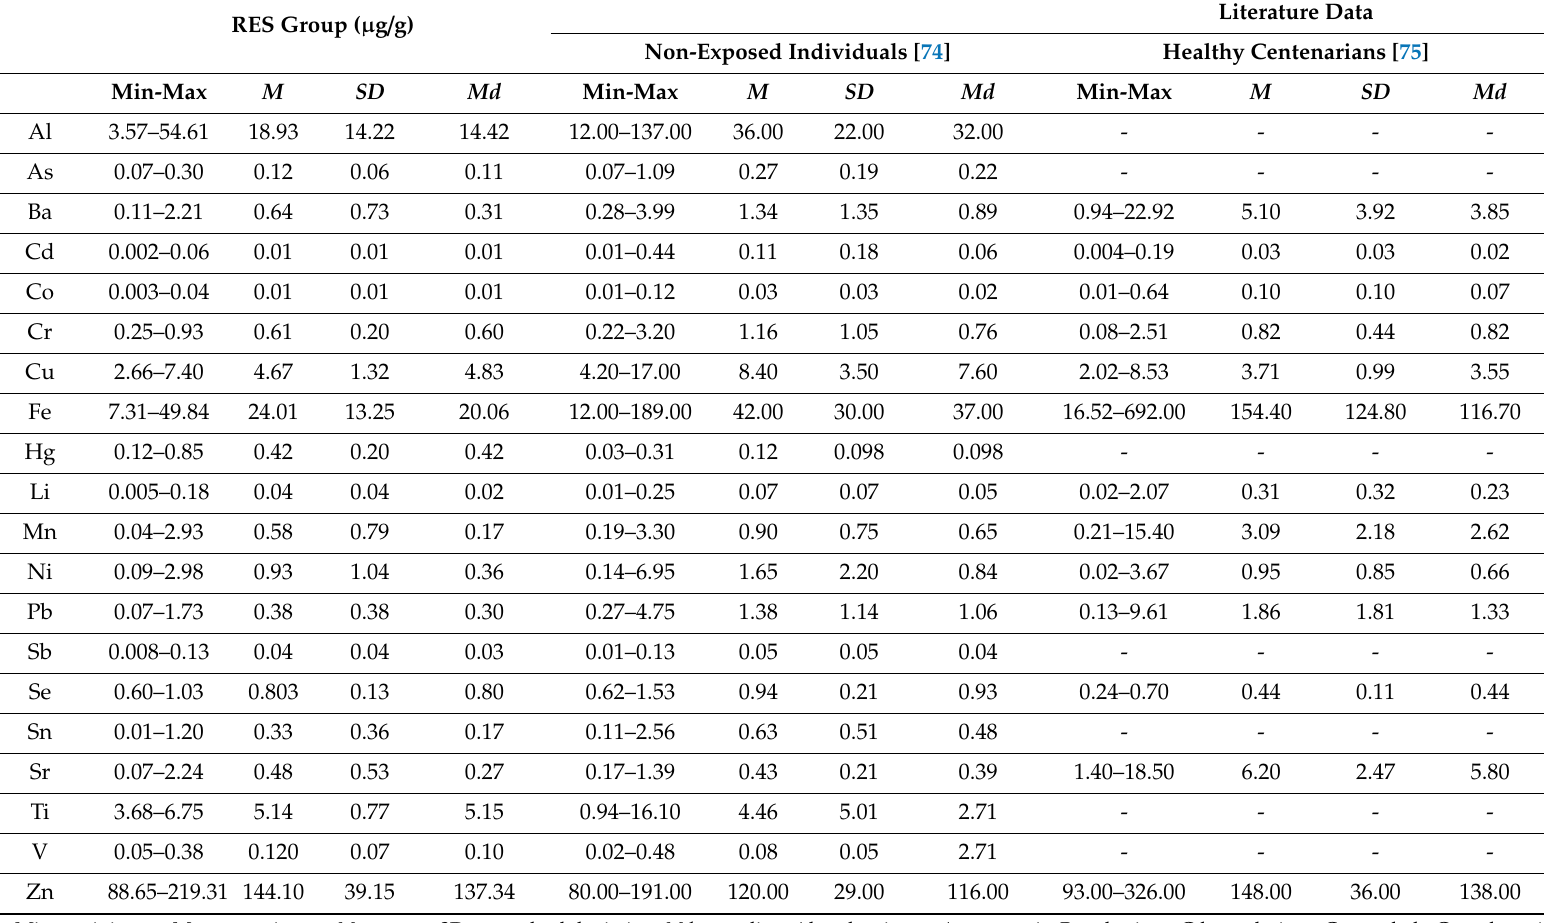
Table 2. Descriptive statistics for the observed trace elements (TE) contents in fingernails (research study-group (RES)), expressed as µ g / g; values reported in the literature are presented for comparison